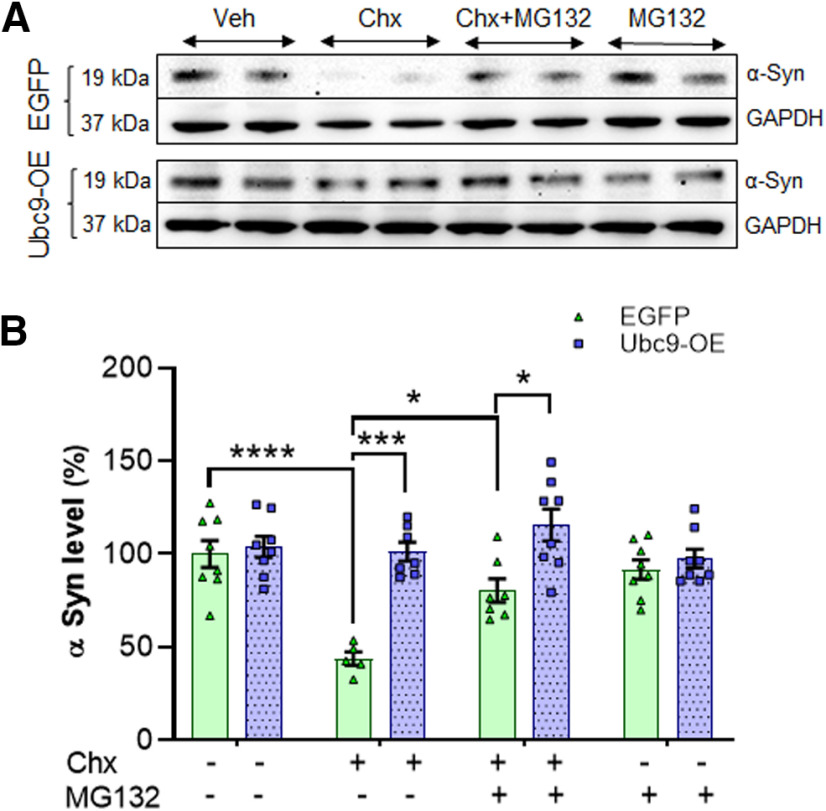
MG132-mediated proteasomal inhibition prevents α-syn degradation in EGFP cells, while it shows no effect in Ubc9 cells in 24-h Chx chase studies. A, In WBs, there is no noticeable effect of MG132 (proteasome inhibitor) in Ubc9 cells, compared with EGFP cells. B, In the analysis of integrated density of WB images, α-syn degradation was significantly interrupted by Ubc9 overexpression compared with EGFP cells. The ratio of α-syn/GAPDH was displayed as mean ± SEM in % of control (n = 6–8 each). Two-way ANOVA was applied to assess the interaction between Ubc9 and MG132 for statistical analysis; *p < 0.05, ***p < 0.001, ****p < 0.0001.